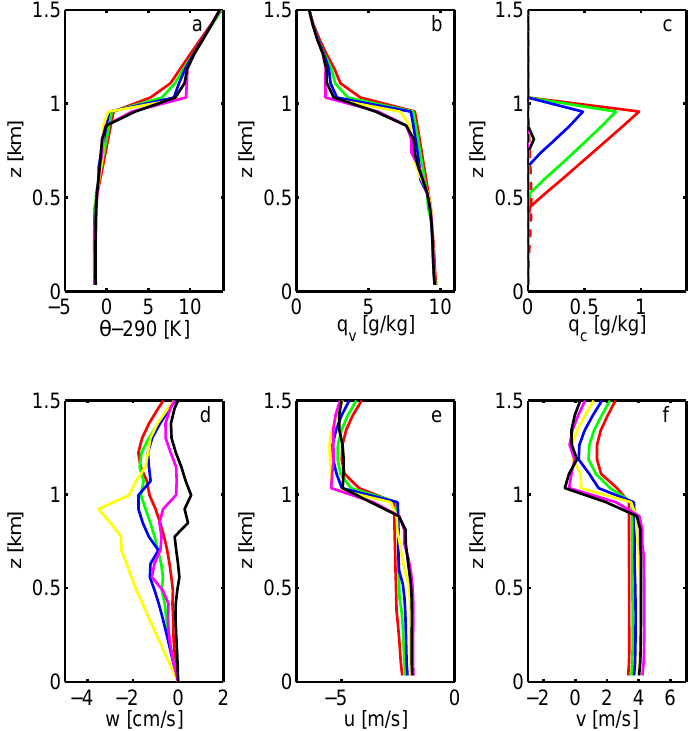
Fig. 11. Profiles of θ (a) , q v (b) , q c (c) , w (d), u (e) , v (f) for location P1 for times 08:30 (red), 09:00 (green), 09:30 (blue), 10 (yellow), 10:30 (magenta), 11:00 (black)